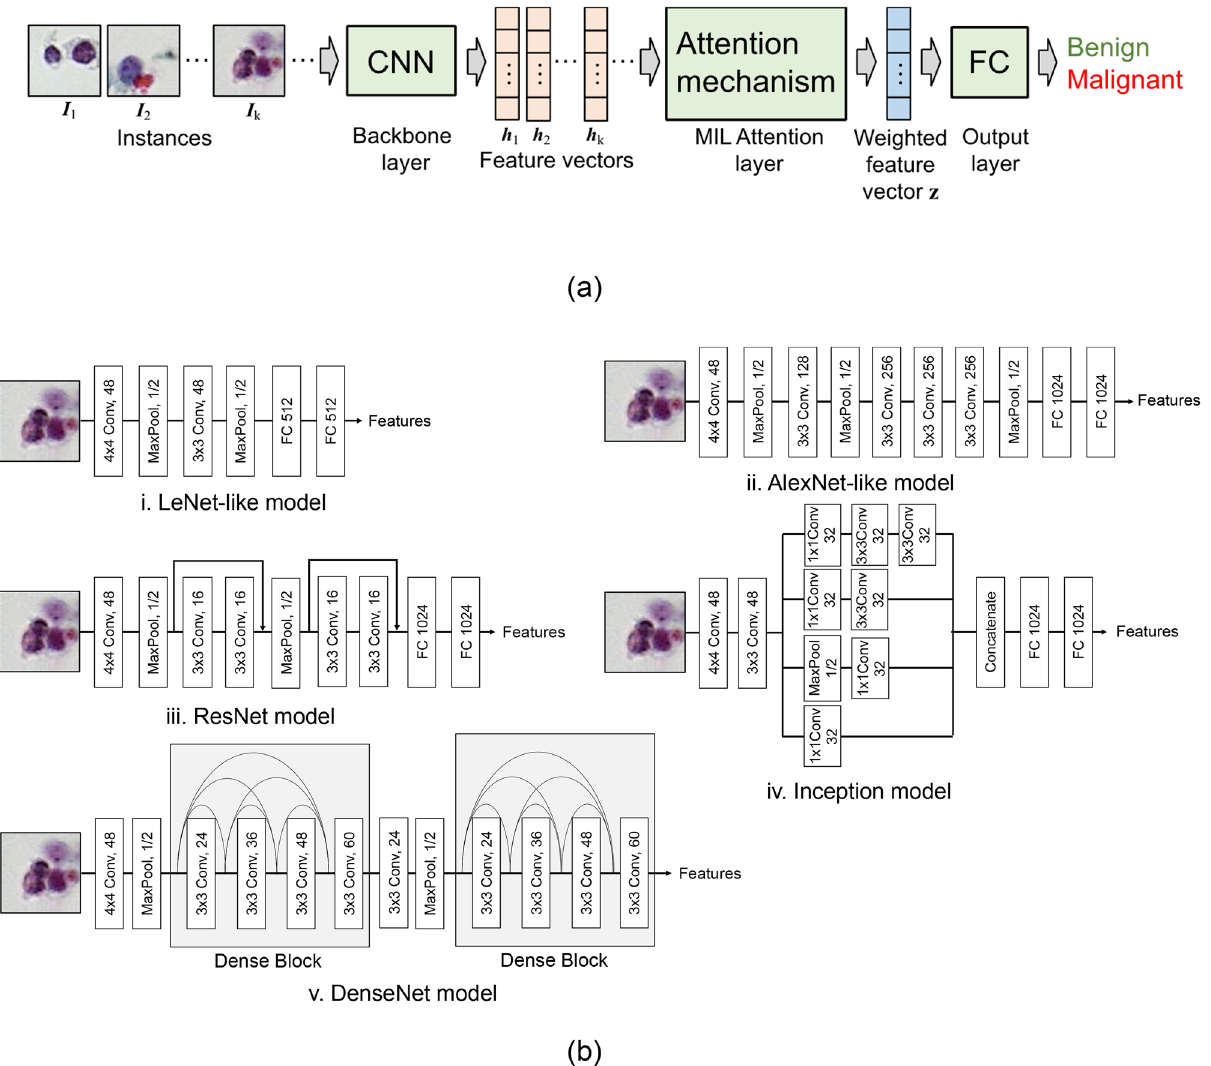
Figure 3. Architecture of the AD MIL. ( a ) Overall structure of the AD MIL. ( b ) CNN model for feature